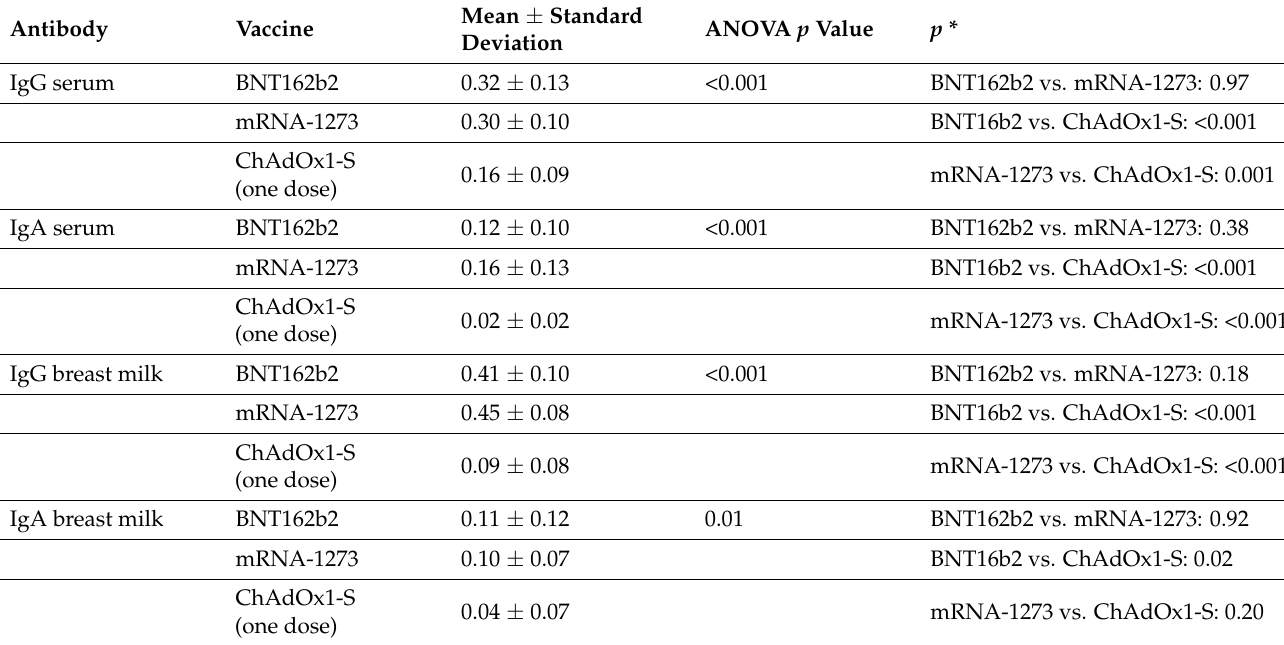
Table 4. Levels of IgG and IgA in serum and breast milk according to the type of vaccine received. Mean ± Antibody Vaccine